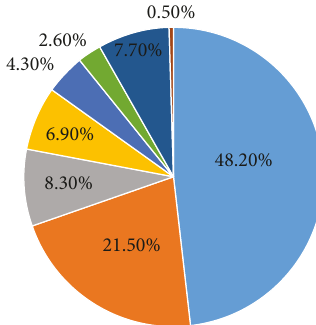
Figure 7: Distribution of shopping tourists’ habitual